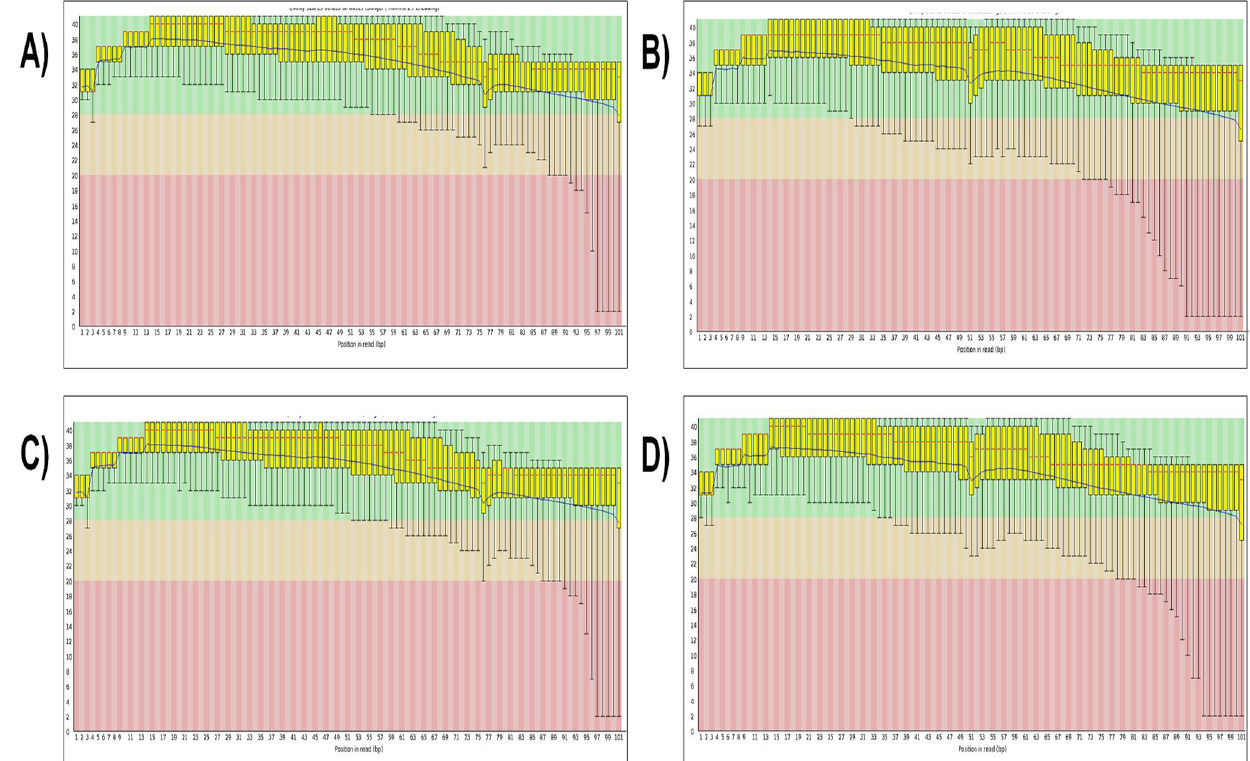
Figure 3. Per base sequence quality of MyoG wd and MyoG kd . Quality scores of A) & B) MyoG wd , and C) & D) MyoG kd . The y-axis on the graph shows the quality scores with higher scores indicating better base calls. The background of the graph separates the y axis into high-quality calls (green), calls of reasonable quality (orange), and calls of poor quality (red). In each of these findings, the red line is the median value, the yellow box corresponds to the inter-quartile range (25–75%), the upper and lower whiskers represent the 10% and 90% points, respectively, and the blue line signifies the mean quality. doi:10.1371/journal.pone.0092447.g003 PLOS ONE |